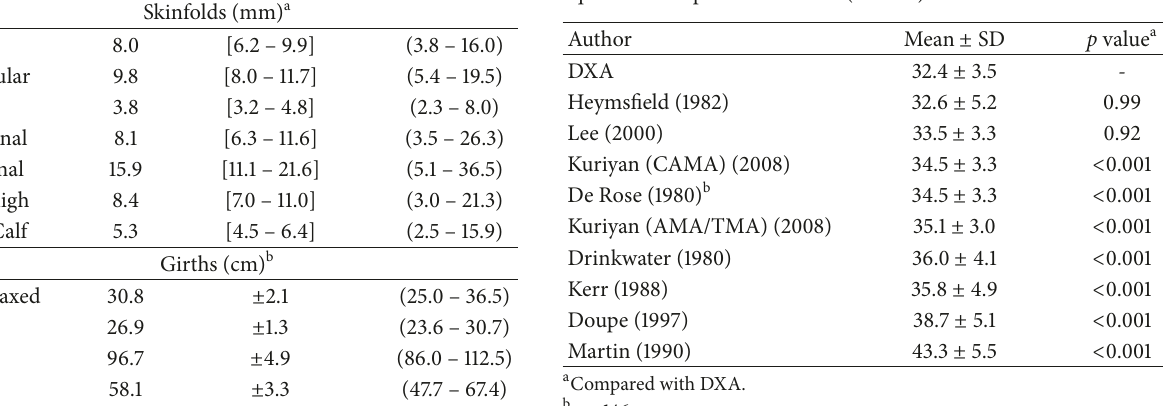
Table 2: Participants’ anthropometric measurements (n = 179). Table 3: Skeletal muscle mass (kg) obtained by anthropometric equations compared with DXA (n =